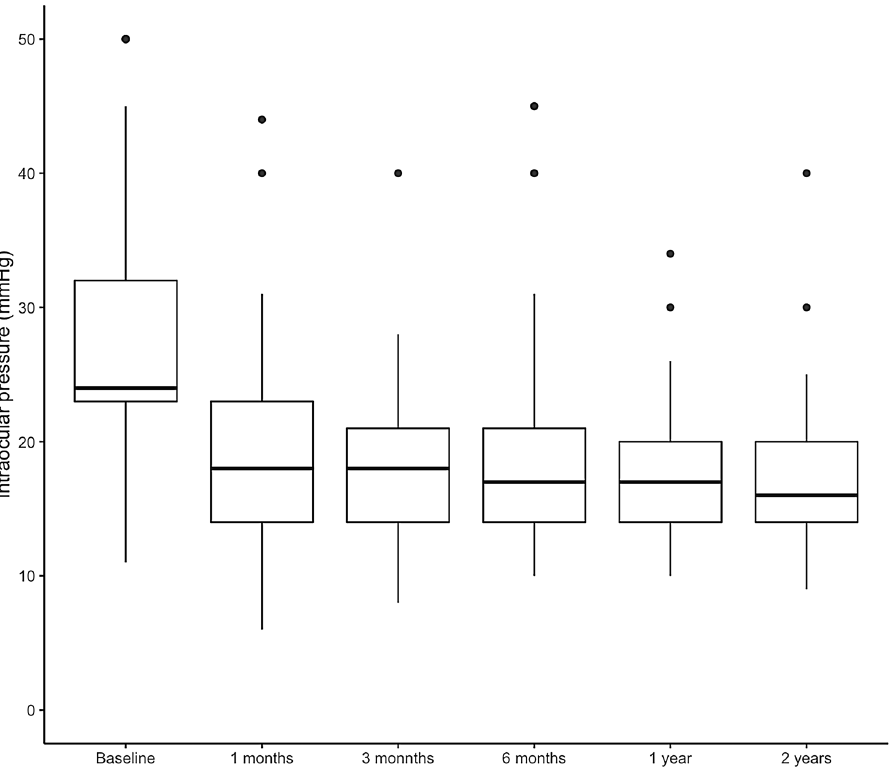
Figure 1. Intraocular pressure values throughout the 2-year follow-up period. The figure was created using R (version 4.0.0) and RStudio (version 1.2.5042) software (https:// www. rstud io. com).